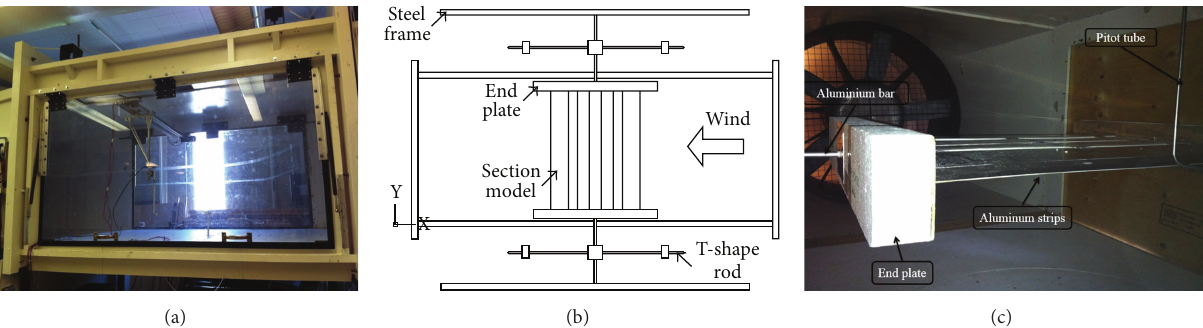
Figure 2: (a) Wind tunnel test section, (b) springs suspension system, and (c) experimental setting of the multibox bridge deck